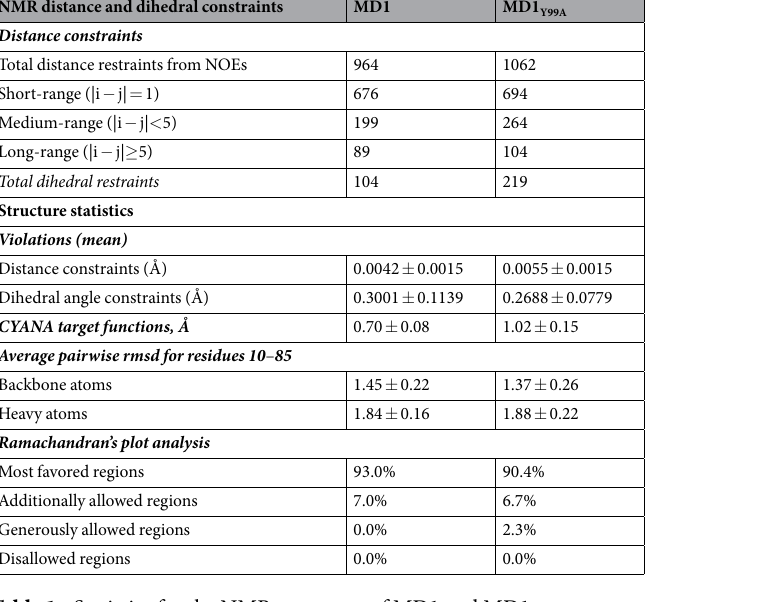
Table 1. Statistics for the NMR structures of MD1 and MD1 Y99A